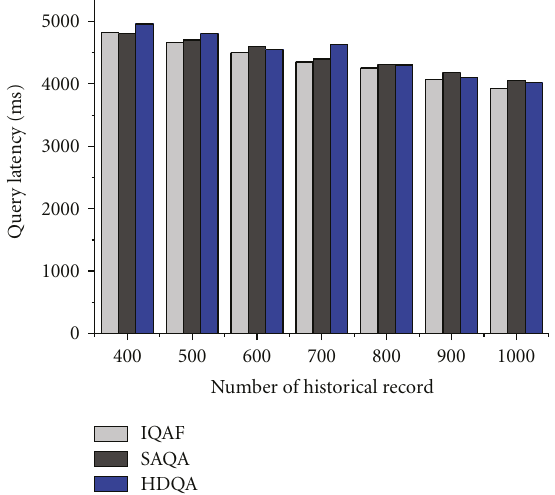
Figure 15: Query latency sensitivity of total query.